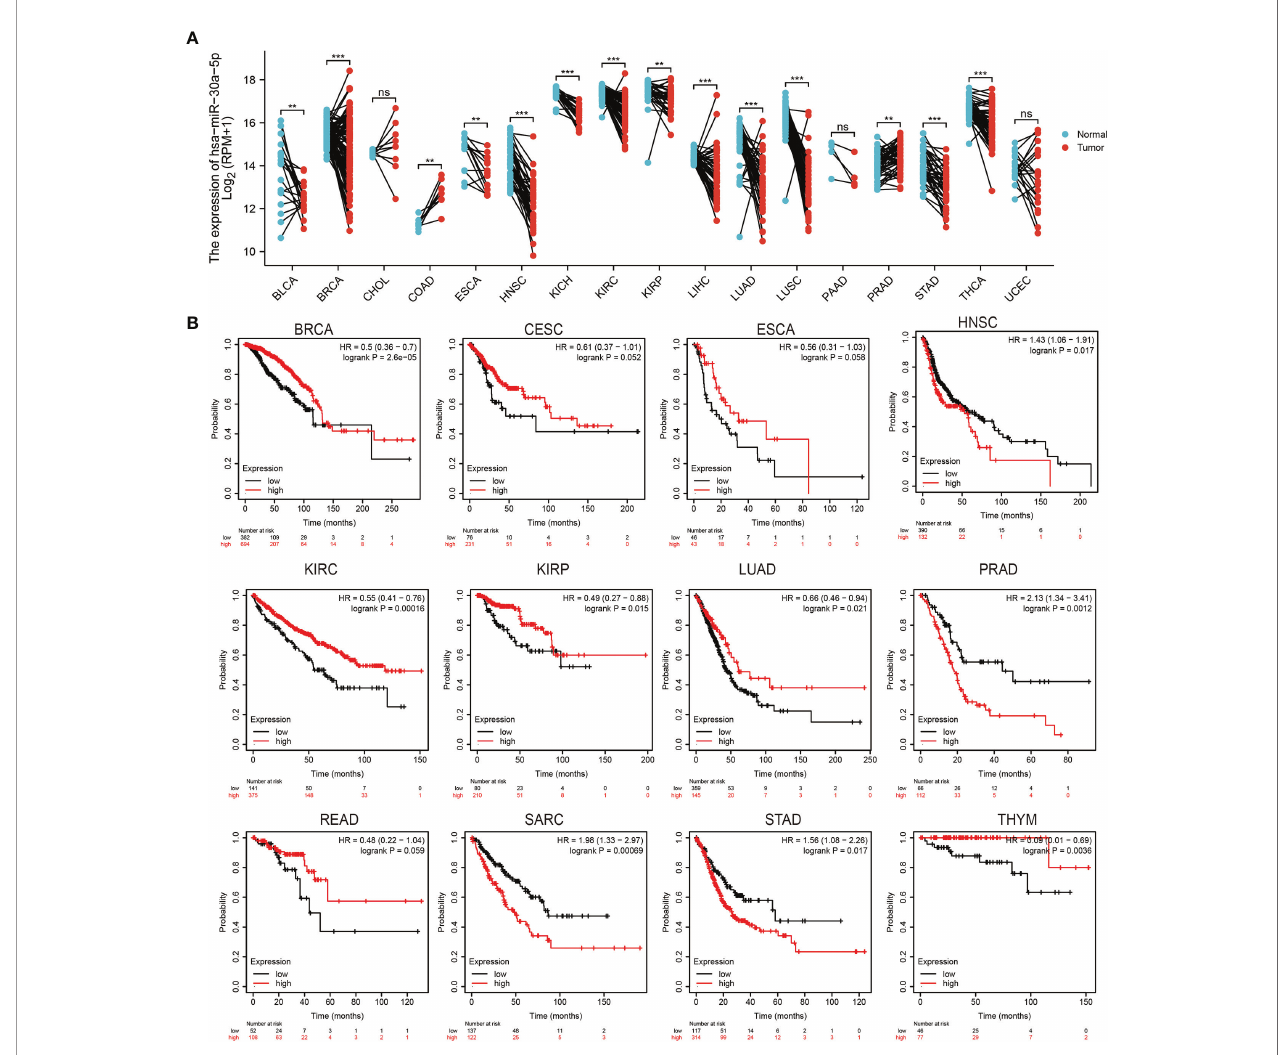
FIGURE 1 | Expression analysis for miRNA-30a-5p in human cancers. (A) The expression of miRNA-30a-5p in pan-cancer. (B) The overall survival of miRNA-30a- 5p in pan-cancer analysed by the Kaplan-Meier Plotter database. **P<0.01, ***P<0.001, NS: p